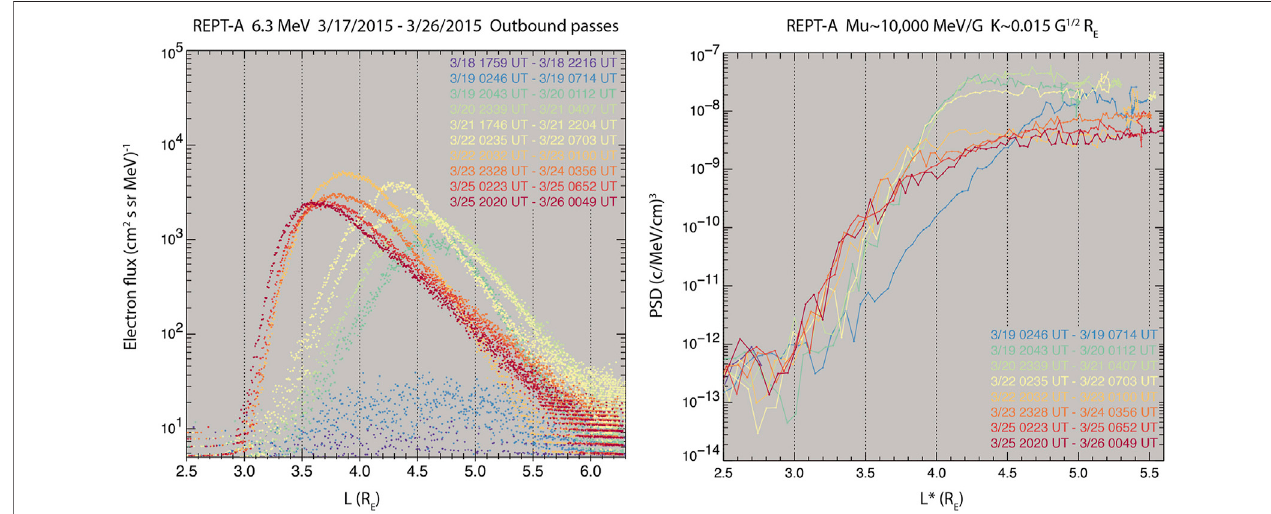
FIGURE 3 | (left) Time evolution of the 6.3 MeV electron fl ux as a function of the normalized equatorial radial distance, L , from 17 March 2015 to 26 March 2015; (right)Time evolutionofthe phase space density (PSD) ofnearequatorialelectronsasafunctionofthe L p coordinate (for a fi rstadiabaticinvariantset to10,000 MeV/G). From Jaynes et al.